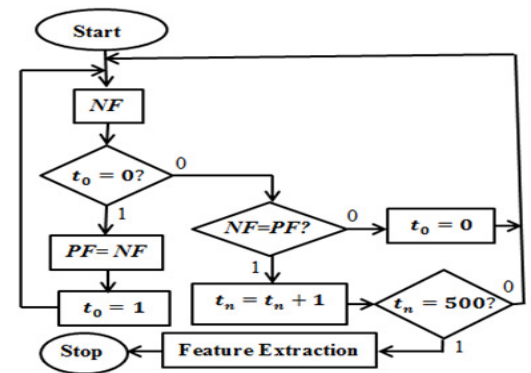
Fig. 7. Schematic of the Time Tick